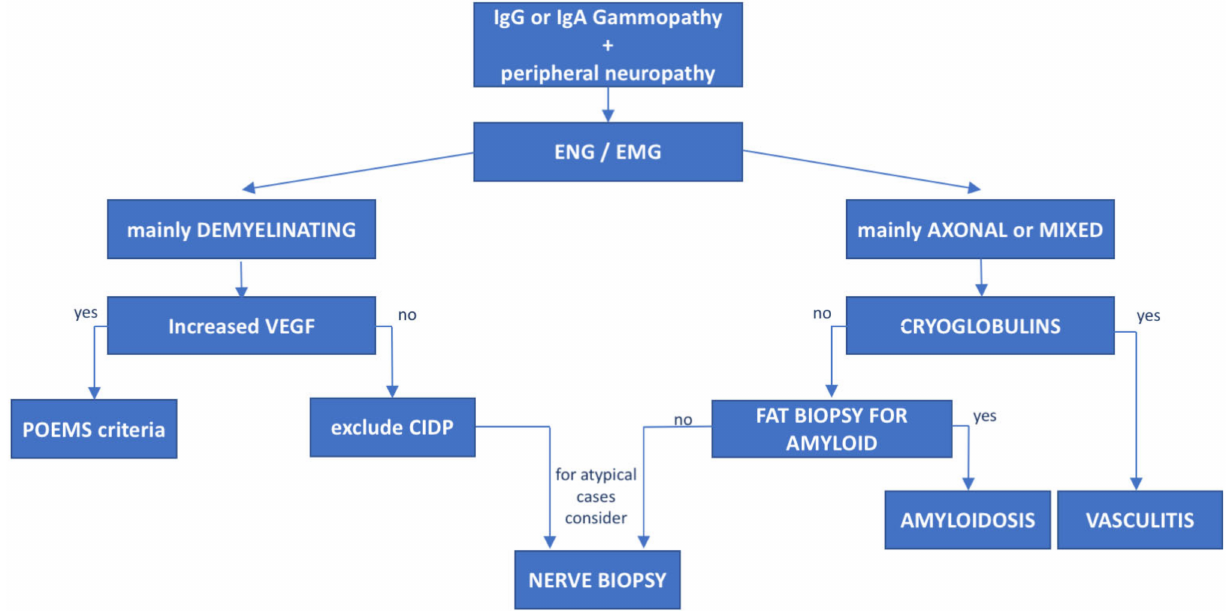
Figure 3. Diagnostic flowchart of peripheral neuropathy associated with IgG or IgA monoclonal gammopathies. Patients with IgG or IgA monoclonal protein and peripheral neuropathy diagnosed with neurophysiological tests (electroneurography (ENG) and electromyography (EMG)) should undergo further investigation based on the type of neuropathy. Mainly demyelinating cases with subacute onset should be tested for VEGF levels to rule out POEMS syndrome. In negative cases, CIDP should be taken into consideration. On the other hand, patients with mainly axonal or mixed (axonal and demyelinating) features cryoglobulins and light-chain amyloid deposition in fat biopsy should be assessed. In atypical or rapidly progressive cases, nerve biopsy may be